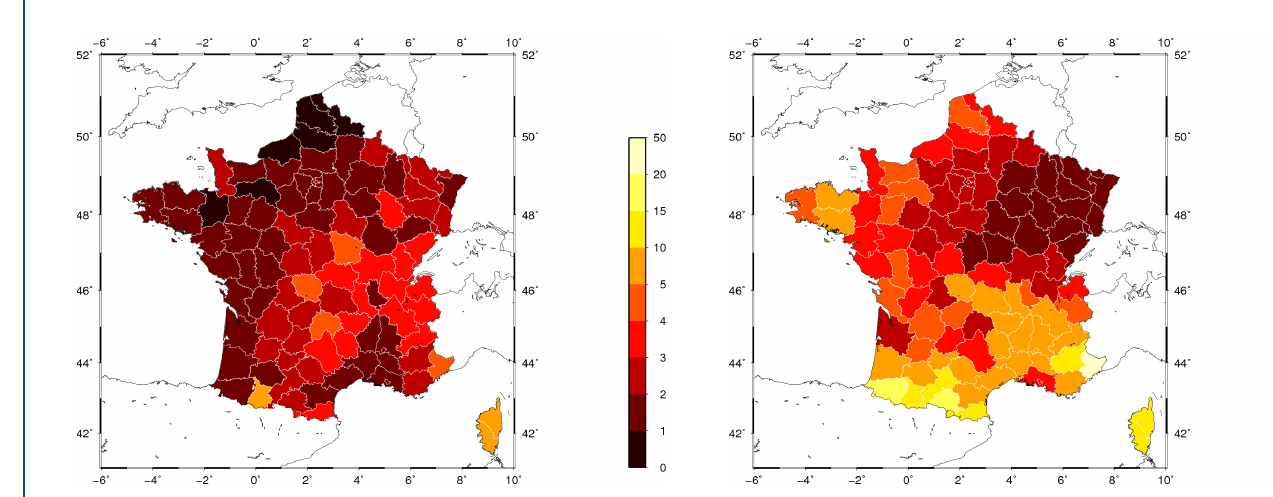
Figure 5. Rank of summer 2018 maximum temperature anomaly per county.